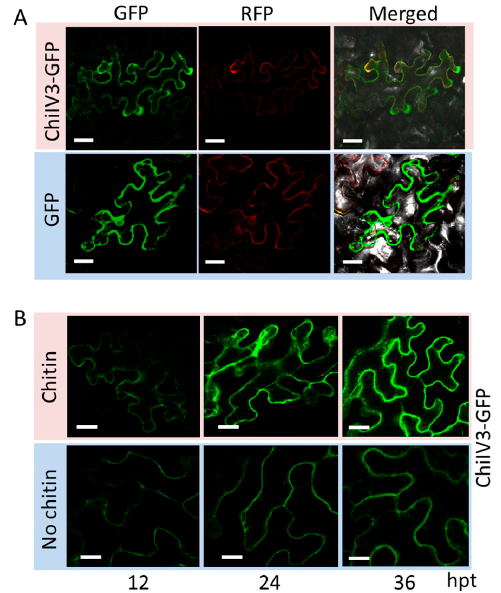
Figure 2. ChiIV3 was located to the plasma membrane and was activated by exogenously applied chitin. ( A ) Confocal images showed representative N. benthamiana leaf epidermal cells transiently expressing ChiIV3-GFP and SRC2-1-RFP both driven by 35S promoter. The fluorescent signals were detected with the confocal microscope DM6000 CS (Leica, Solms, Germany) at 48 h after Agro -infiltration. Bars = 50 μ m; ( B ) ChiIV3 activation during MAMP (chitin) triggered immunity. Time-lapse imaging of pChiIV3:ChiIV3-GFP expressed in N. benthamiana leaves. After chitin treatment, the fluorescent signals were detected at 12 h intervals. Hpt, hours post treatment. Bars = 50 μ m.